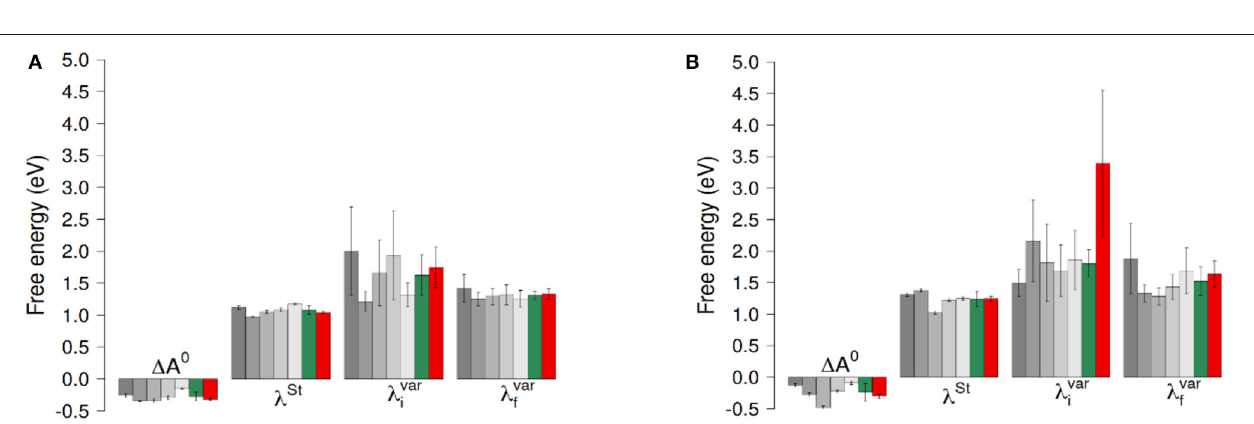
FIGURE 4 | ET reaction free energies and outer-sphere reorganization energies of the ET between hemes with O 2 (A) and without O 2 (B) . The gray bars represent values obtained for the five 100ns-long data sets. The green bars are the results of a block average using the data of these five data sets. The red bars correspond to values obtained using the full 300ns-long trajectory. Error bars correspond to twice the uncertainty.